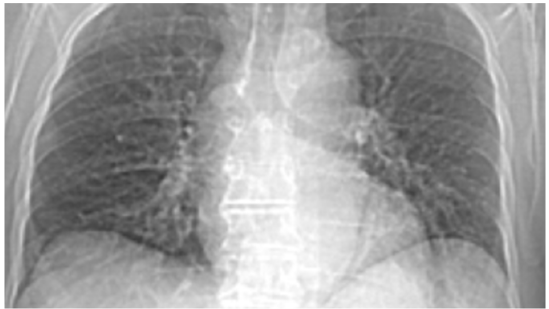
Figure 22. Selecting the portion of interest of the lung for patient AG.